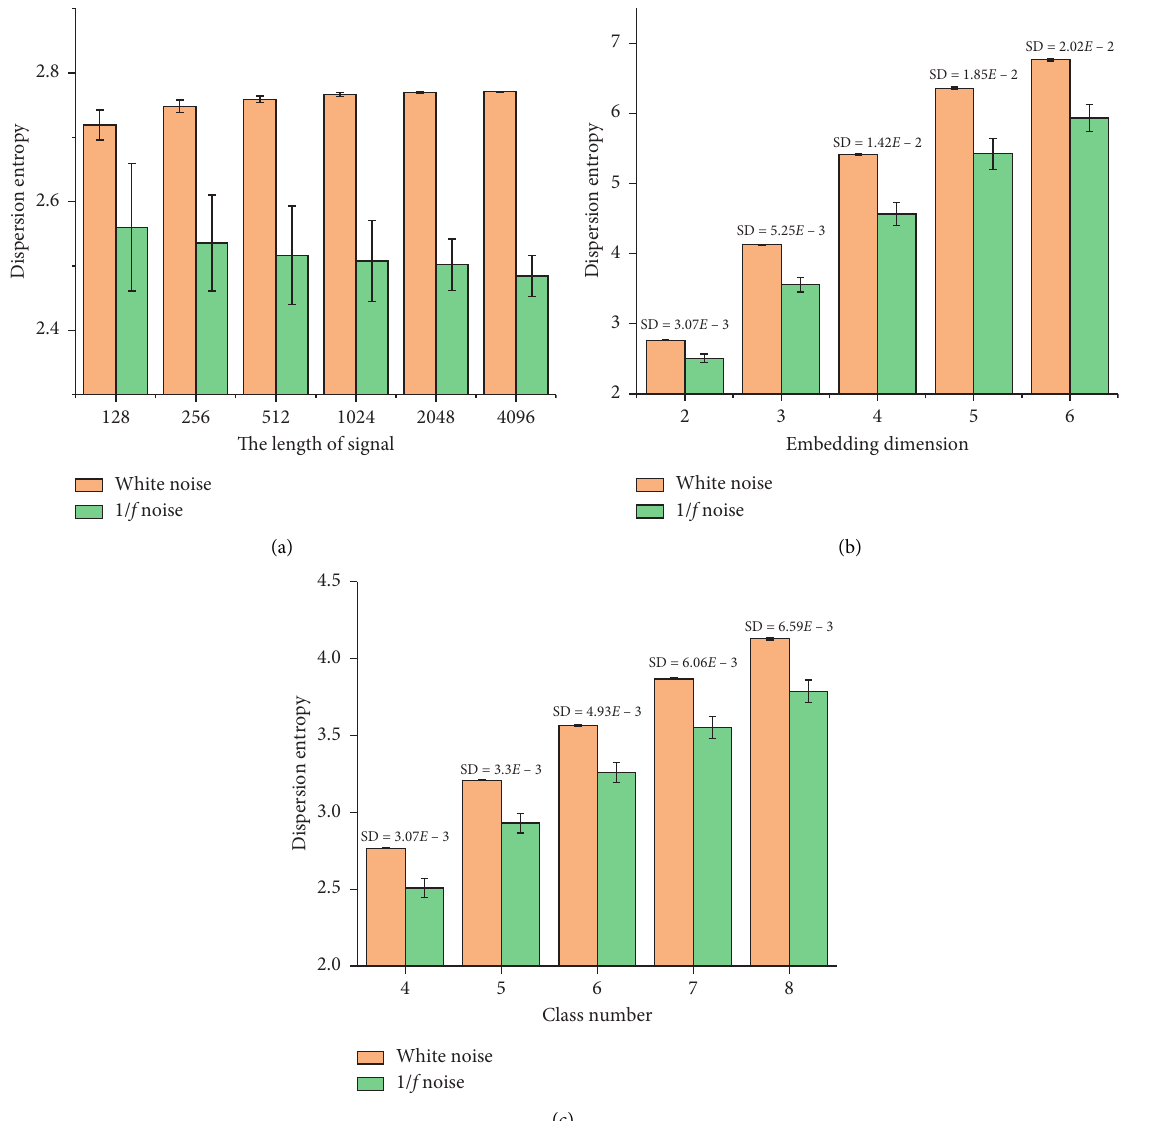
Figure 4: The mean and standard deviation of DE for 50 sets of white noise and 1/ f noise under different parameters. (a) Different length of signal. (b) Different embedding dimension. (c) Different class